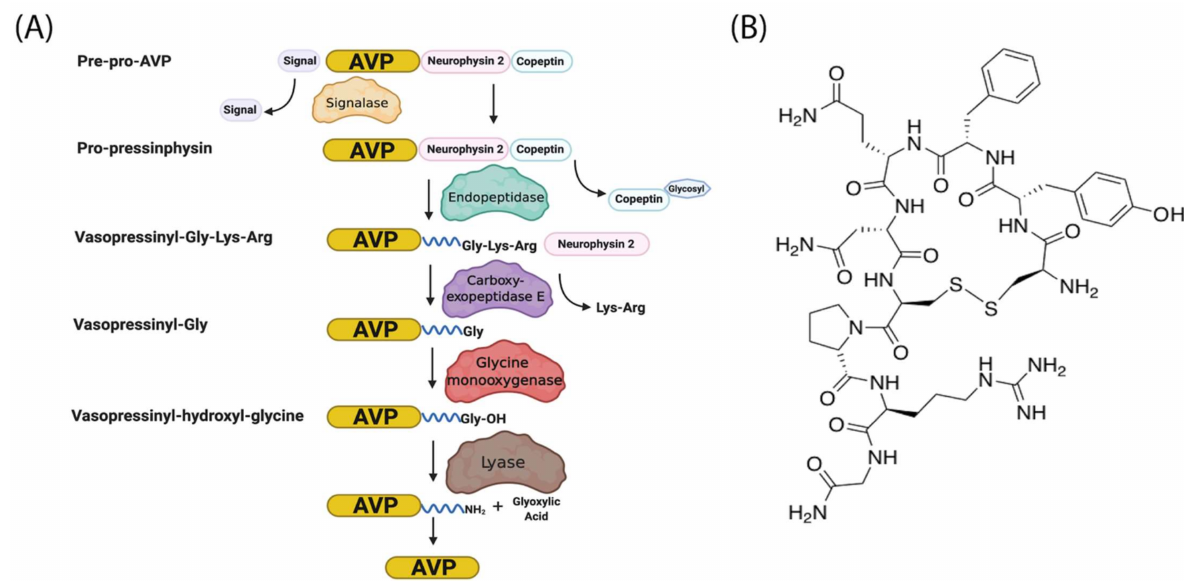
Figure 1. AVP (arginine vasopressin) synthesis and structure. ( A ) The hypothalamic neurosecretory neurons synthesize the pre-pro-hormone precursor called pre-pro-AVP or AVP-neurophysin-copeptin. The signal peptide is cleaved by a signalase in the endoplasmic reticulum to form pro-pressinphysin. Copeptin is glycosylated and cleaved by an endopeptidase in the Golgi [8,35,45]. Such endopeptidase also separates the pro-AVP vasopressinyl-Gly-Lys-Arg peptide from neurophysin, and pro-AVP is enclosed in vesicles. The C-terminal arginine and lysine are trimmed by carboxypeptidase E and the newly exposed C-terminal glycine is oxidized by glycine monooxygenase into hydroxyl-glycine. Finally, a lyase converts hydroxyl-glycine is into an amide group which subsequently reacts with glyoxylic acid to yield AVP [45]. ( B ) AVP structure. Note the cyclic structure and primary amide (NH 2